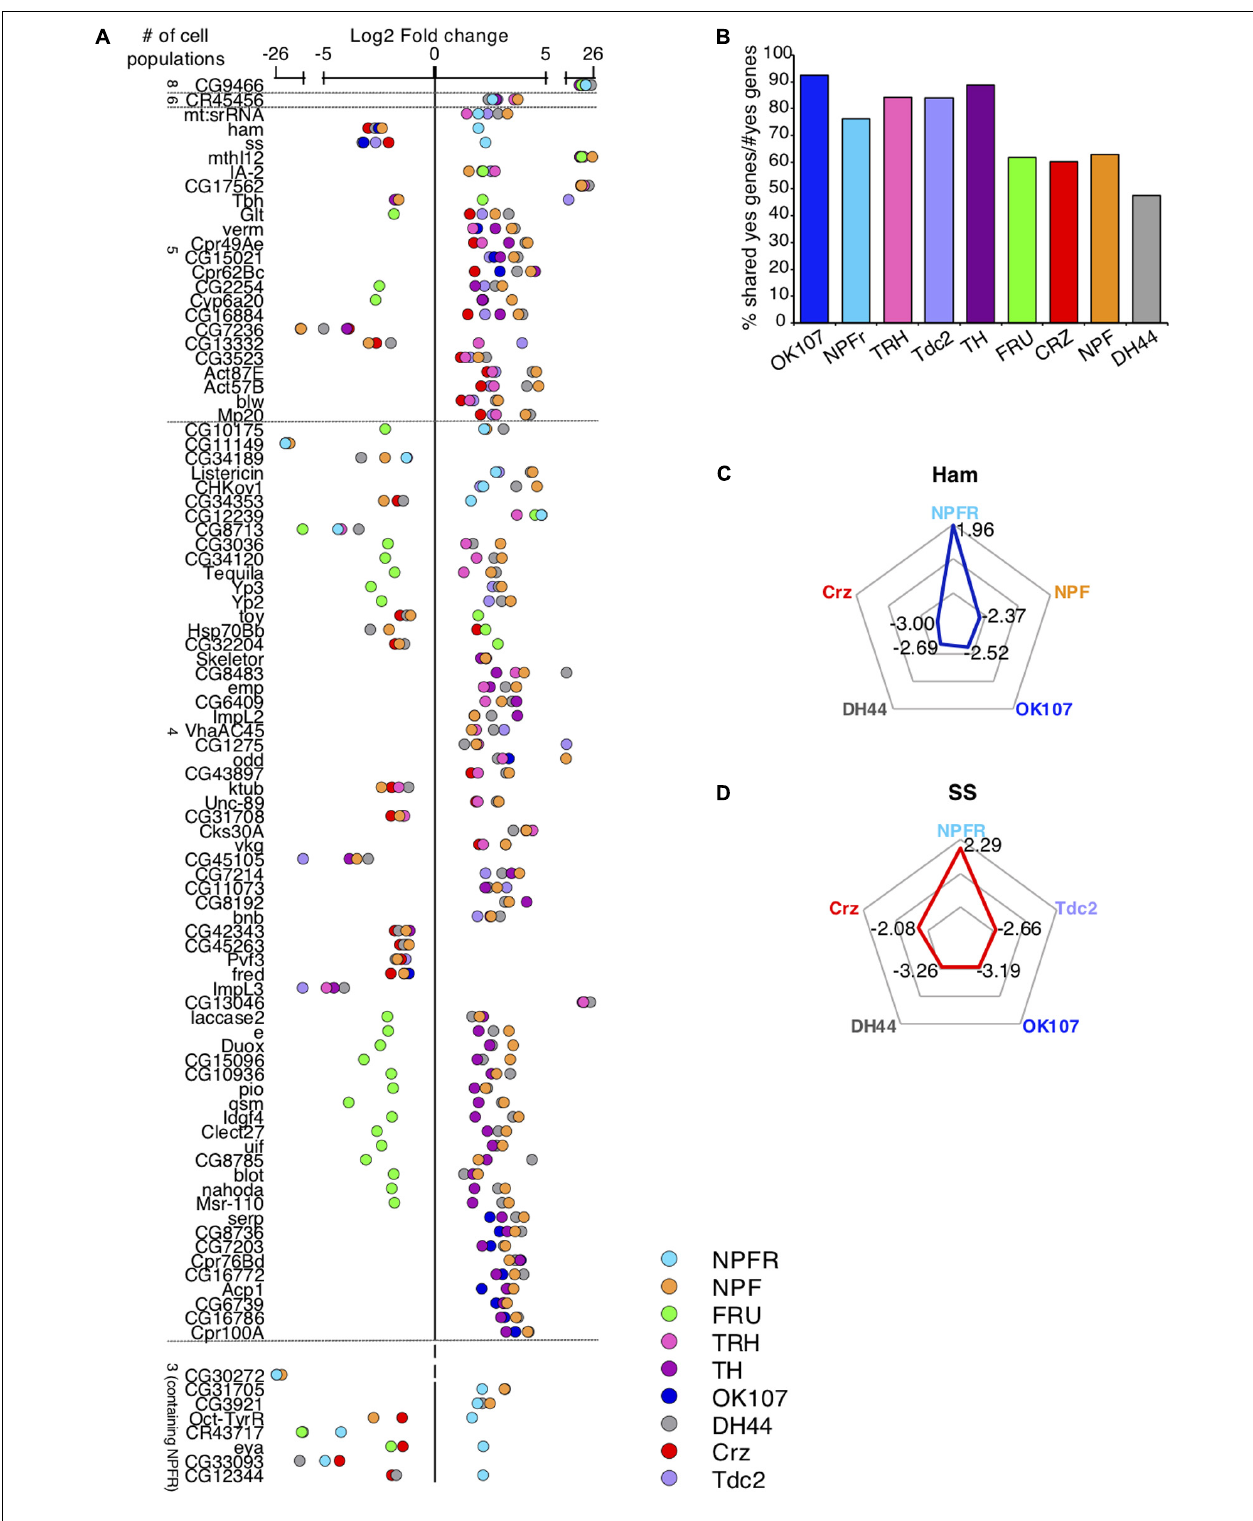
FIGURE 2 | Certain DEGs are shared across many populations. (A) Scatter plot representing log 2 -fold change of all genes that are differentially expressed compared to ElaV and are shared across 8–4 different cell populations (upper part) and across 3 populations containing NPFR (bottom part). (B) Percent of shared DEGs normalized by total number of DEGs in each neuronal population. (C,D) Radar plots of two DEGs: ham (C) and ss (D) both of which were enriched in NPFR cells compared to 4 other cell types.